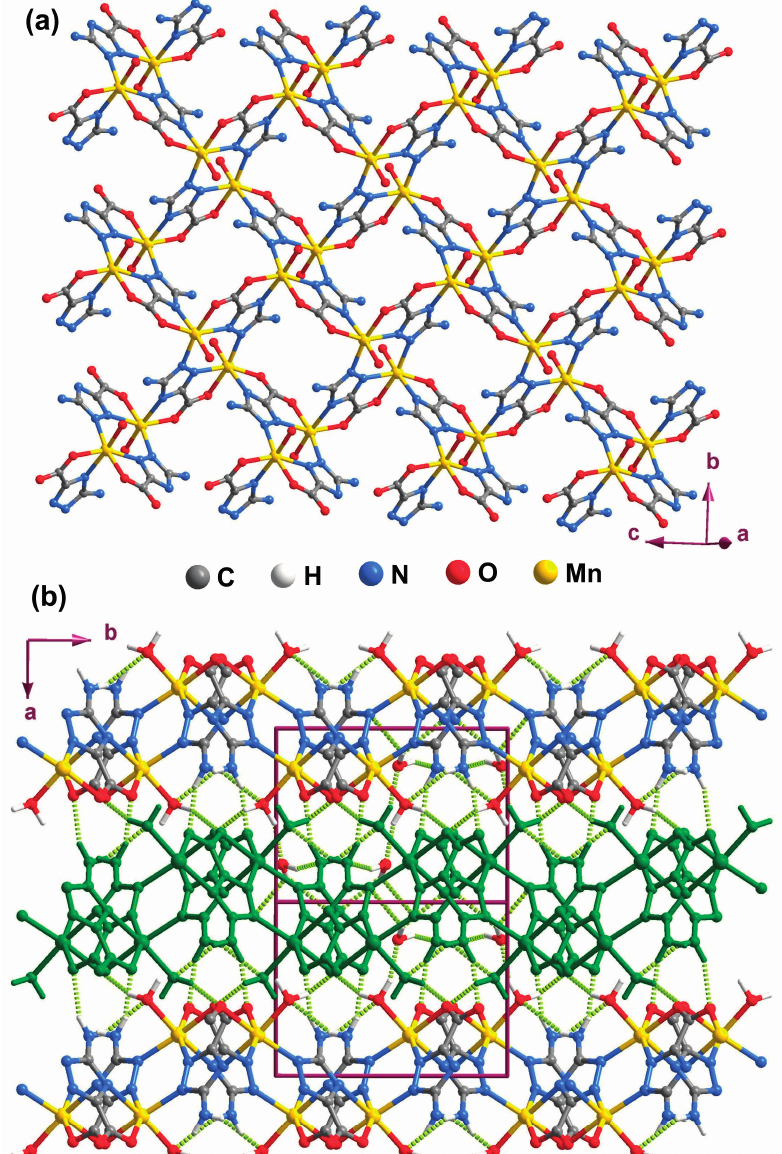
Figure 10. Ball-and-stick representation of ( a ) the 2D coordination layer and ( b ) 3D hydrogen-bonded network viewed along the [001] direction of the unit cell of compound 5 (layers represented with alternating colors). Hydrogen bonds are represented as dashed light-green lines. Geometric details on the represented supramolecular interactions are listed in Table